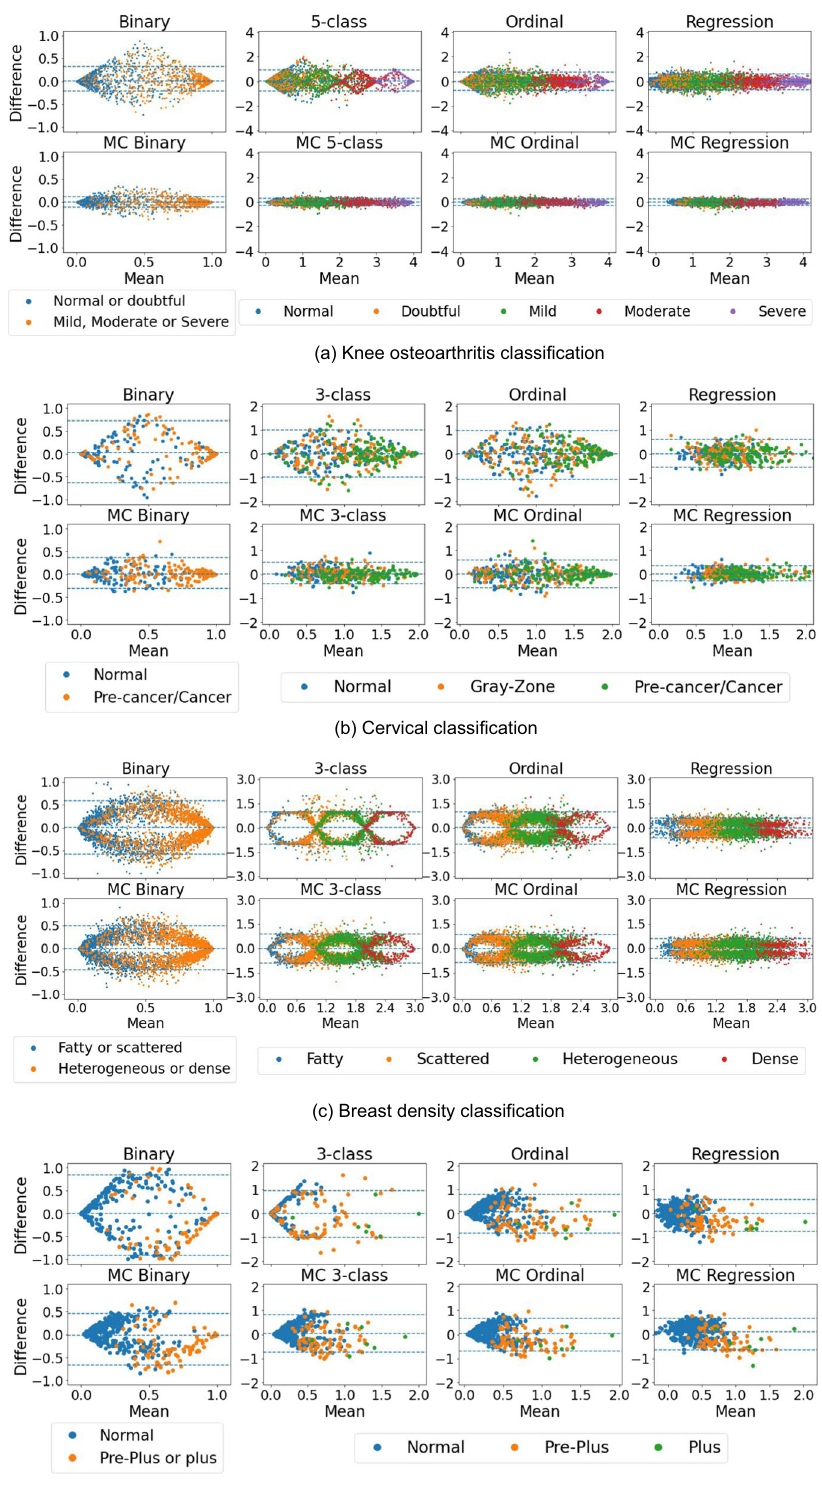
Fig. 2 Bland-Altman plots on multiple images from the same patient and visit. The y-axis of each graph represents the maximum difference in model prediction for images of the same patient, while the x-axis refers to the mean of the predicted scores. ( a ) Knee osteoarthritis, ( b ) cervical, ( c ) breast density, and ( d ) ROP classi fi cation. The 95% limits of agreement are presented with dashed blue lines. Repeatable models are associated with differences and limits of agreement closer to zero which indicates a smaller difference between test and